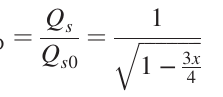
FIG. 4. Comparison between GALACLIC (in red) and Laclare [29] (in black) of the normalized mode-frequency shifts, in the case of a broadband resonator impedance (with a quality factor of 1 and a resonance frequency f taking into account the PWD and for a parabolic amplitude density (PAD) longitudinal distribution [29]: (left) real part and (right) imaginary part (from GALACLIC